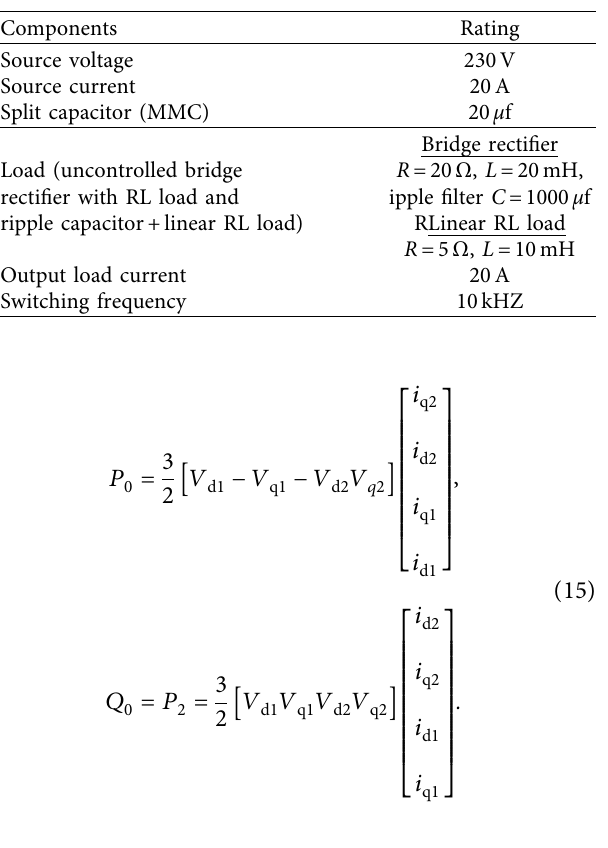
Table 2: Specifications of the proposed